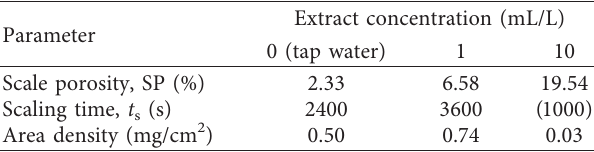
Table 4: Scale parameters obtained in the electrochemical scaling